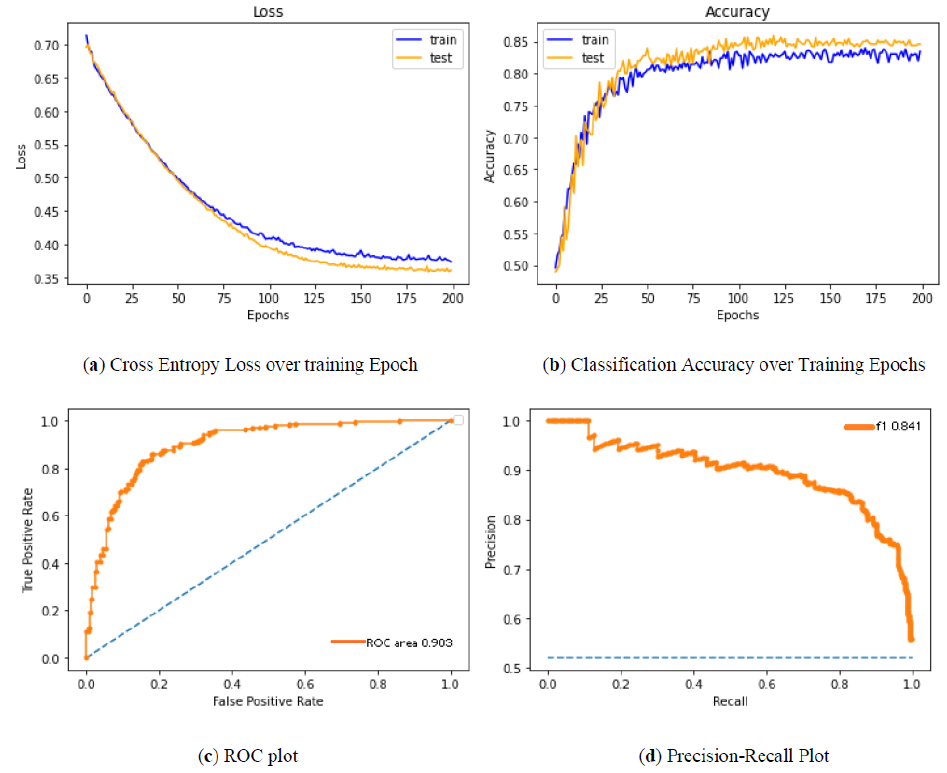
Figure 6. ( a – d ) Performance analysis of the proposed method.